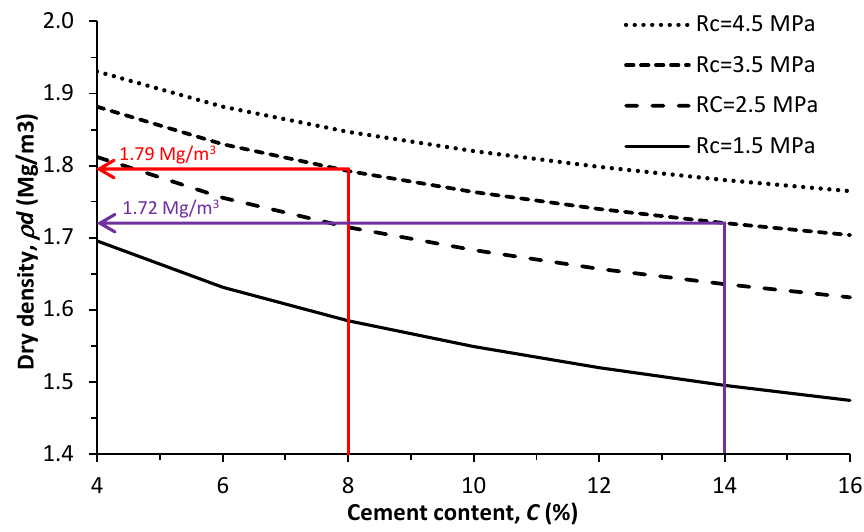
Figure 13. Practical examples of mix design.